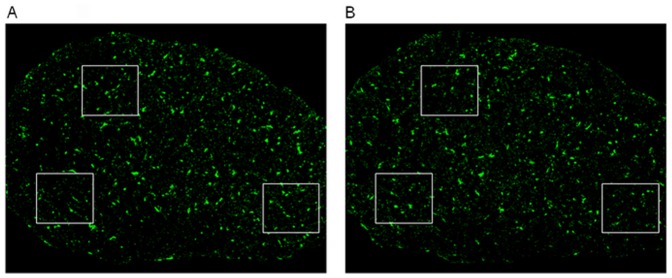
Observations of two consecutive slices from the same nerve in the control eye.(A) Slice near the eye. (B) Slice away from the eye next to (A). The distribution and fluorescence quantity were different between the two consecutive slices as indicated by White Square. Scale bar, 100 µm (White Line).